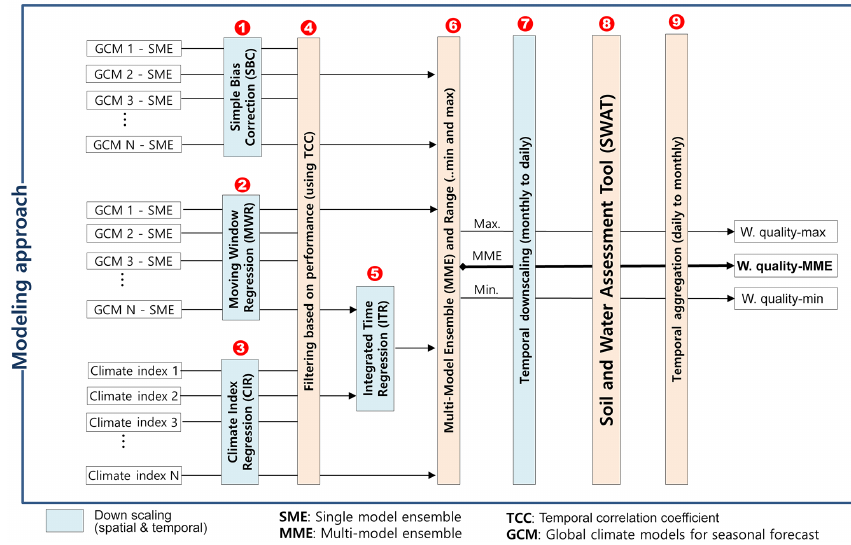
Figure 1. Flow chart of integrated seasonal climate and water quality forecasting based on a modeling